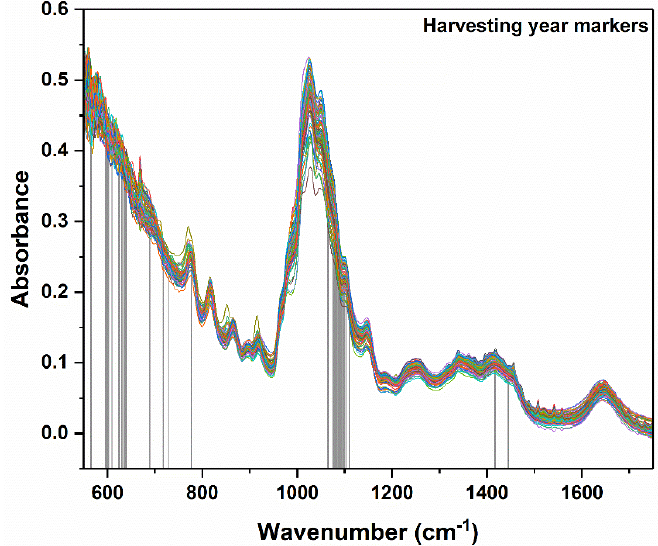
Figure 2. Plotted spectra of all investigated samples (for their differentiation distinct colors were used). The vertical lines marked the spectral points having high differentiation power for the harvesting year discrimination of the investigated honey samples.